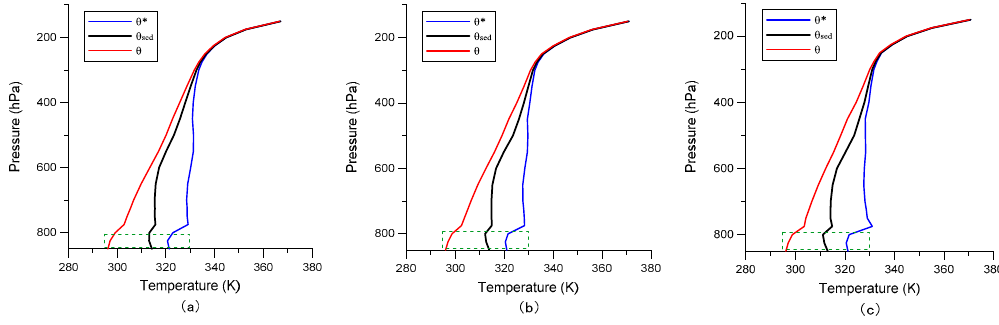
Figure 3. The 3 θ distribution conditions at the center location: ( a ) 12:00; ( b ) 15:00; and ( c ) 18:00 UT on 30 July 2017. Red, green, and blue lines are the θ , θ sed , and θ * curves, respectively. Area indicated by the dotted green box is the unstable area.